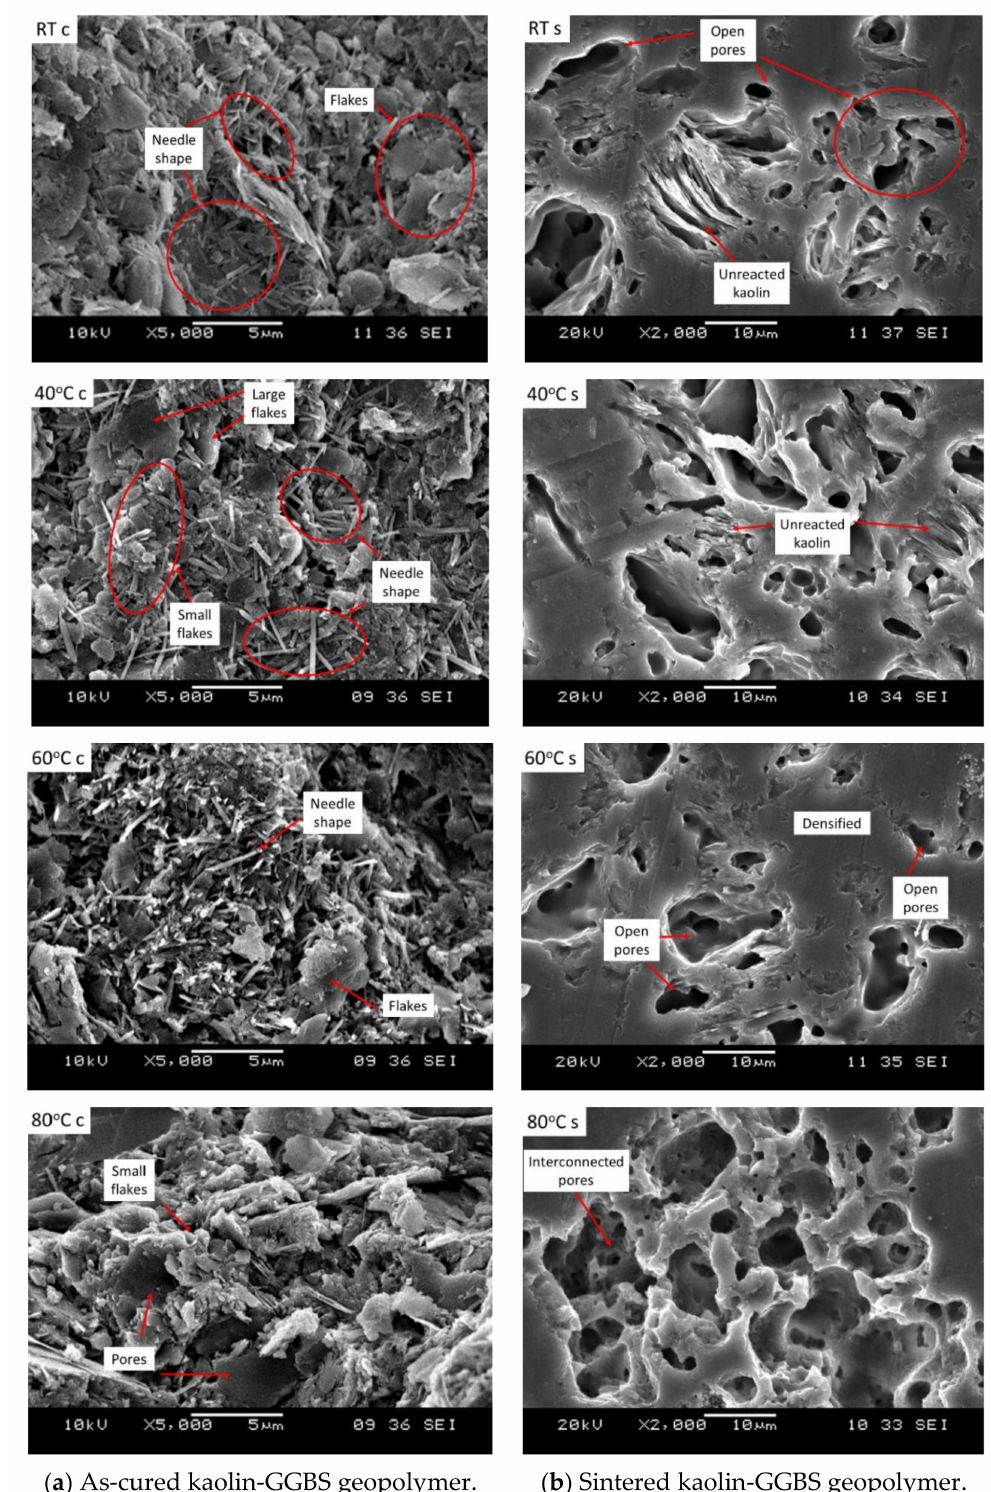
Figure 9. Microstructure of as-cured ( a ) and sintered ( b ) kaolin-GGBS geopolymer samples, at different curing